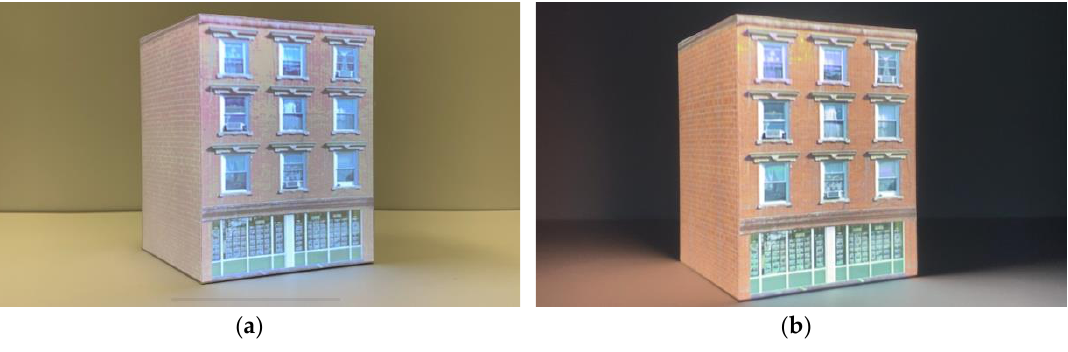
Figure 5. Comparison of projection results with illumination condition. ( a ) Projection with environmental electric light; ( b ) Projection without environmental light.